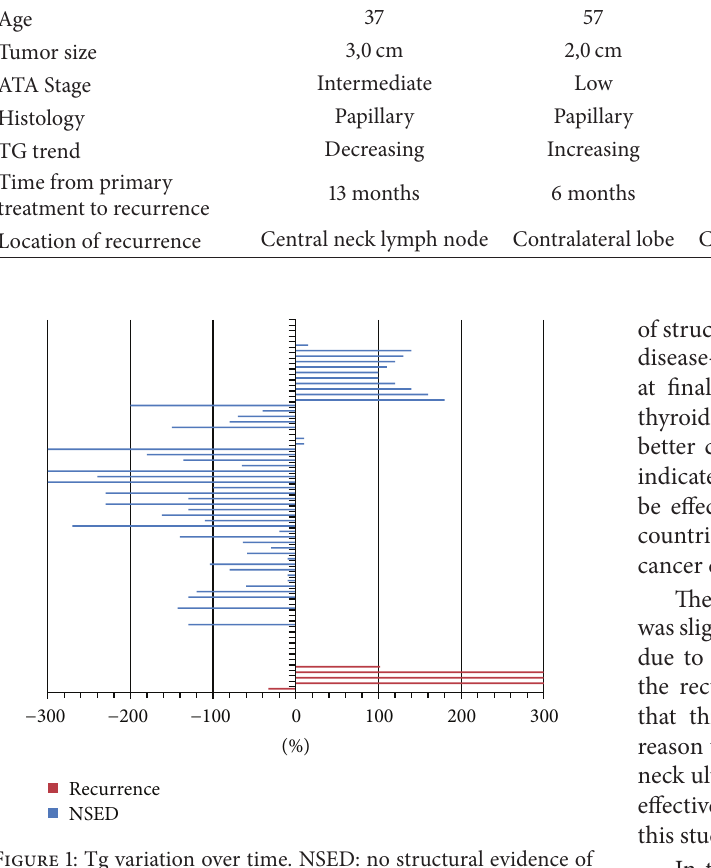
Figure 1: Tg variation over time. NSED: no structural evidence of disease. Variations under 20% were considered stable, 𝑃 = 0.01